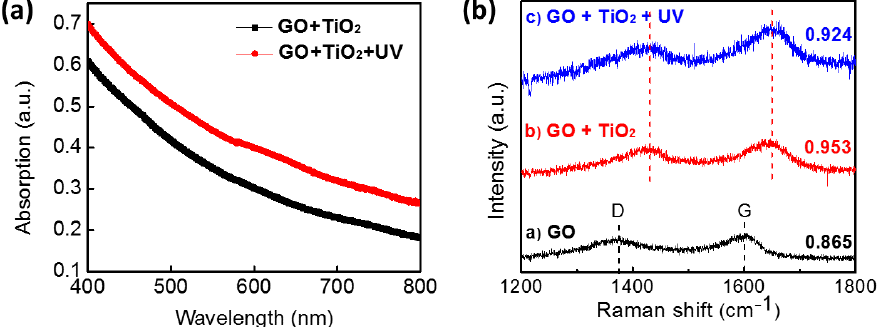
Figure 3. ( a ) UV-vis absorption spectra of GO/TiO 2 composite before and after UV irradiation. ( b ) Raman spectra of (a) GO, (b) GO/TiO 2 composite, and (c) GO/TiO 2 composite with UV irradiation.